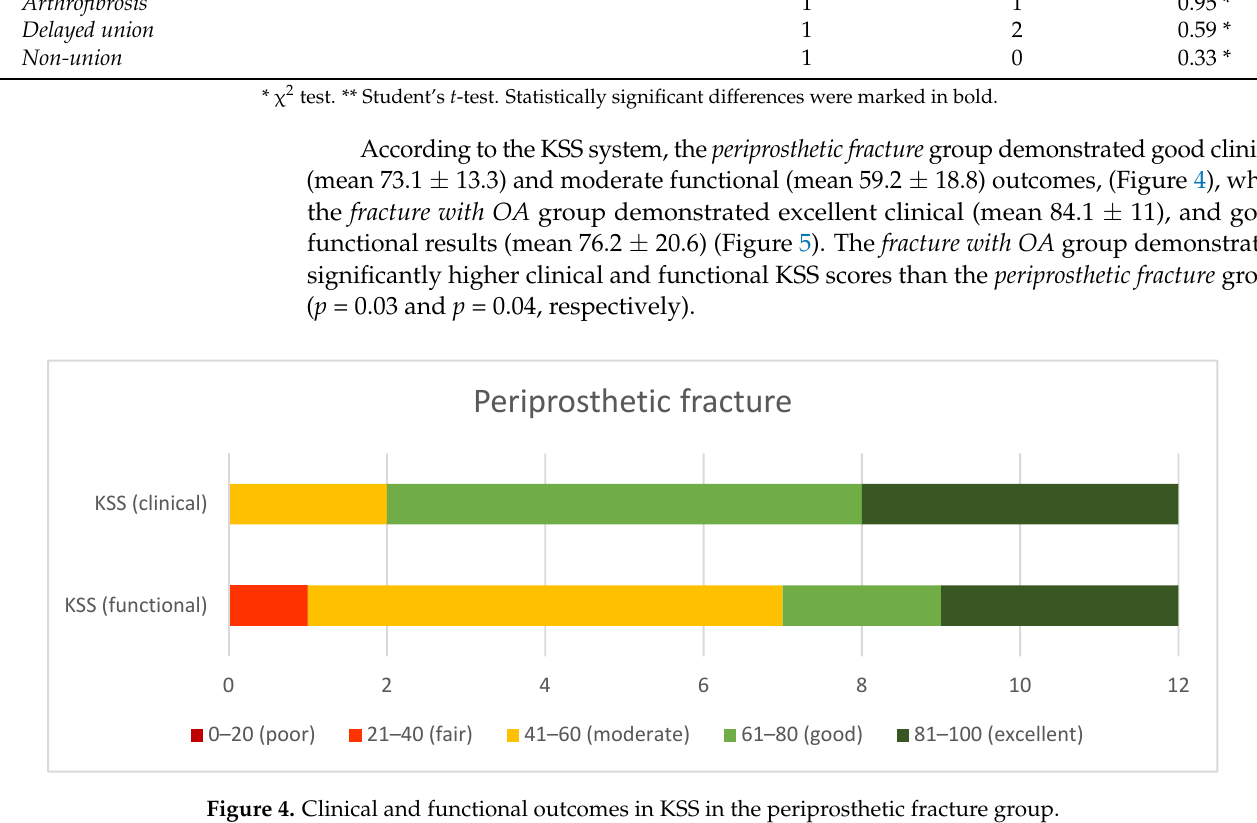
Figure 4. Clinical and functional outcomes in KSS in the periprosthetic fracture group.